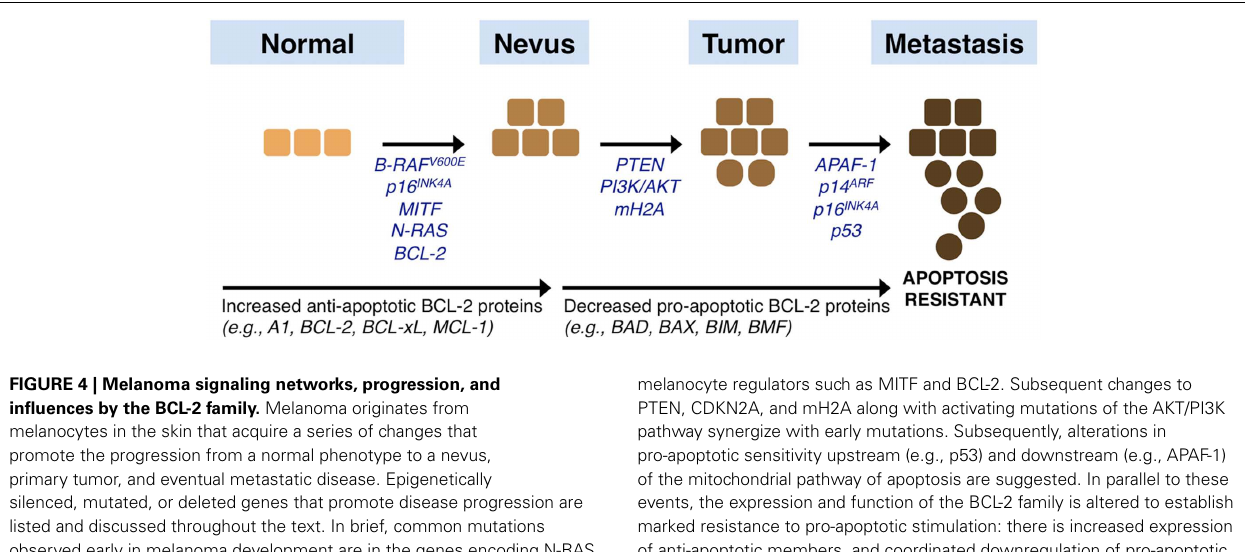
FIGURE 4 | Melanoma signaling networks, progression, and influences by the BCL-2 family. Melanoma originates from melanocytes in the skin that acquire a series of changes that promote the progression from a normal phenotype to a nevus, primary tumor, and eventual metastatic disease. Epigenetically silenced, mutated, or deleted genes that promote disease progression are listed and discussed throughout the text. In brief, common mutations observed early in melanoma development are in the genes encoding N-RAS and B-RAF, and these are often complemented by mutations in the